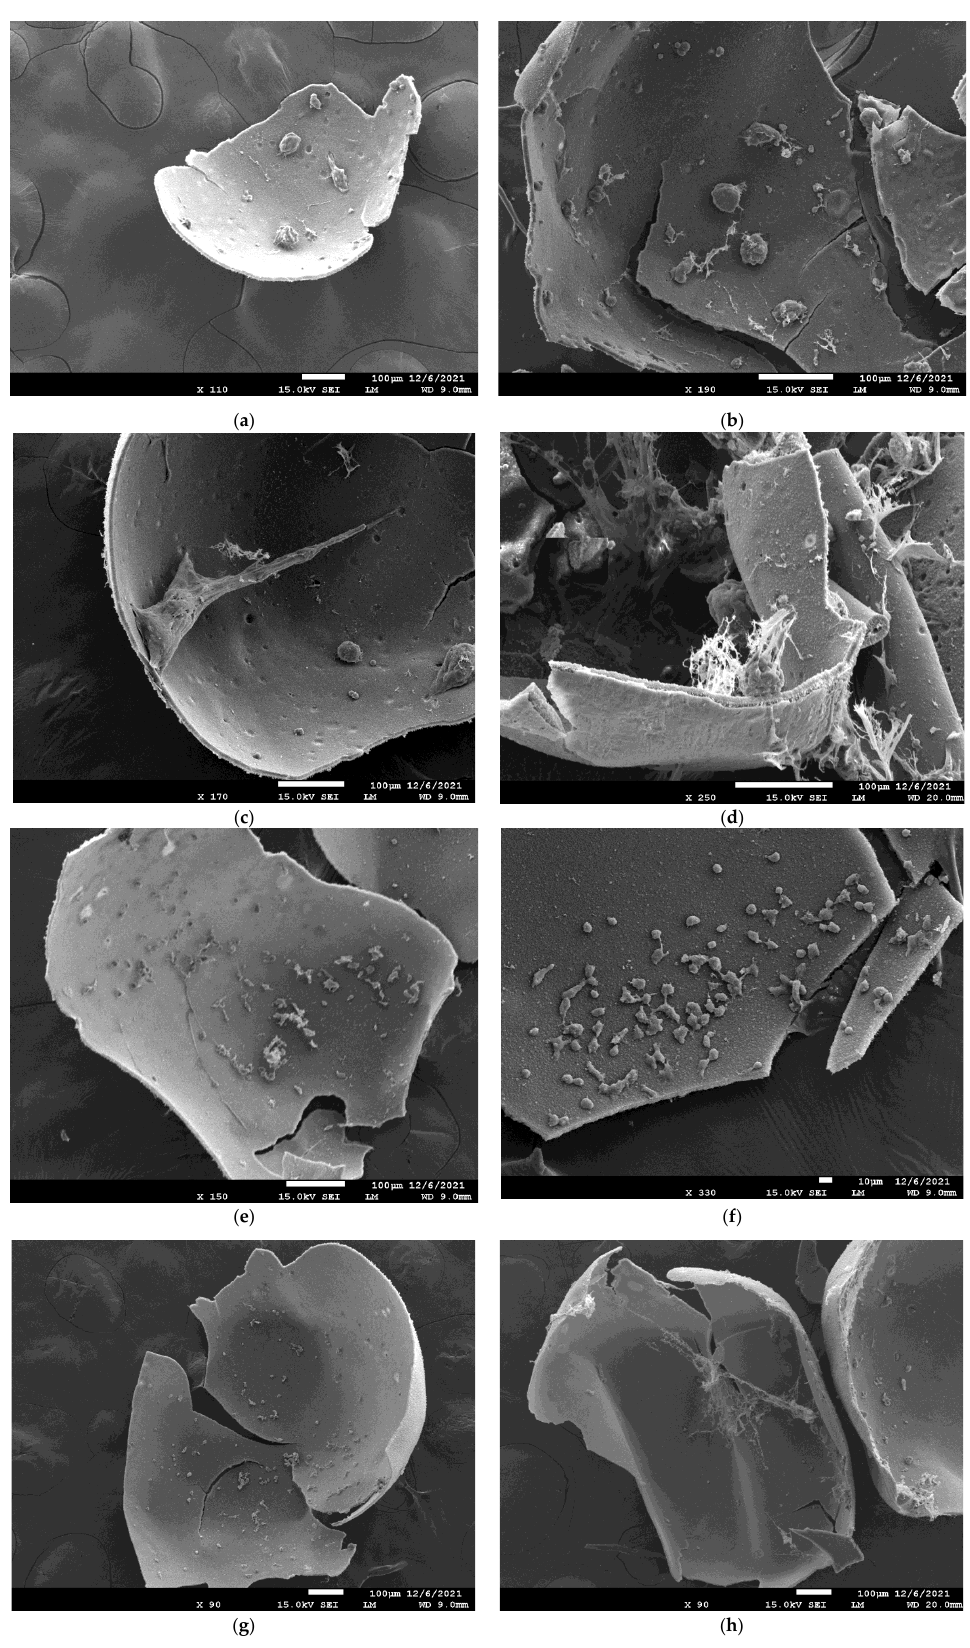
Figure 9. The SEM images of the 28-day chondrocyte and bMSC encapsulated cultures. ( a ) Chon- drocytes day 7; ( b ) chondrocytes day 14; ( c ) chondrocytes day 21; ( d ) chondrocytes day 28; ( e ) bMSC day 7; ( f ) bMSC day 14; ( g ) bMSC day 21; ( h ) bMSC day 28.